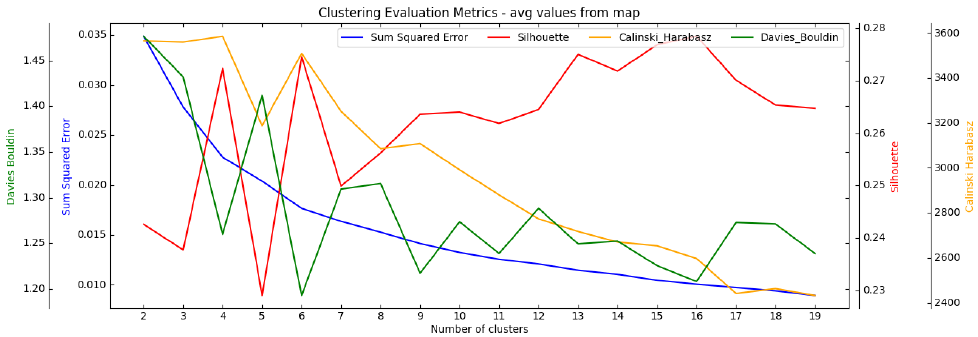
Figure 3. Clustering evaluation metrics for average values per sensor.